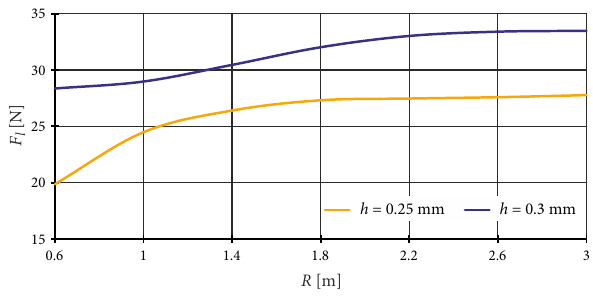
Figure 5. Dependence of the load capacity F l of the BGD on the radius R of curvature of the surface of the content of the transportation object